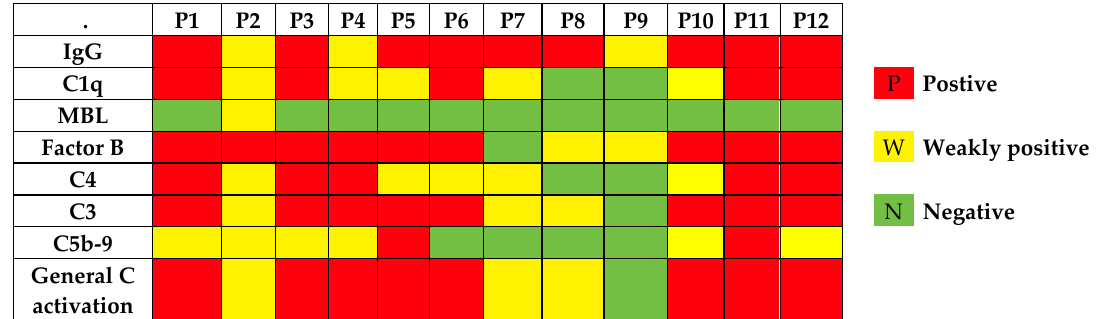
Table 3. Complement deposition in lungs.